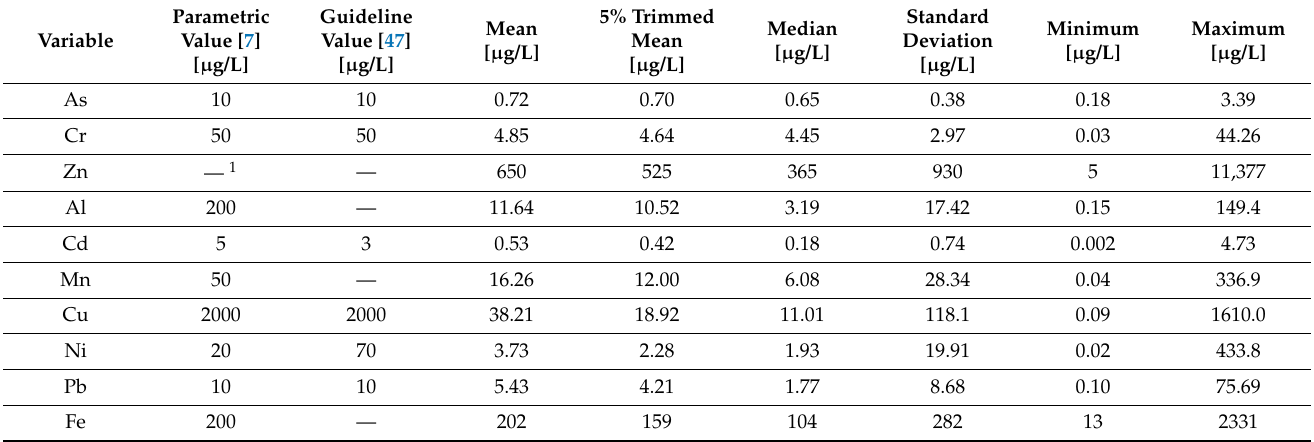
Table 5. Statistics for trace elements concentrations in the collected water